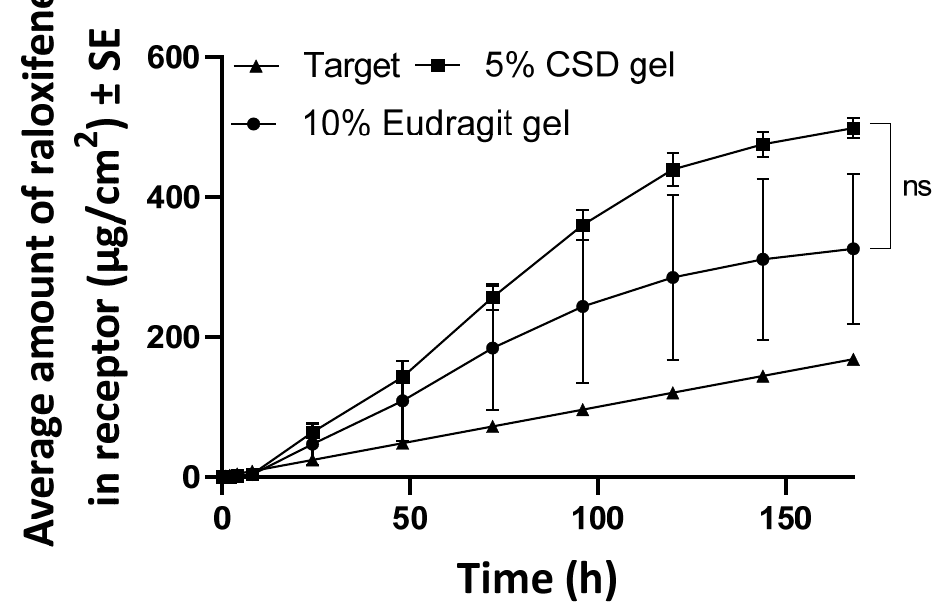
Figure 7. Permeation profile of raloxifene from infinite dosing of gels. Statistical analysis was per- formed with a Mann–Whitney test. ns indicates a significant difference between groups ( n = 4, p > 0.05).